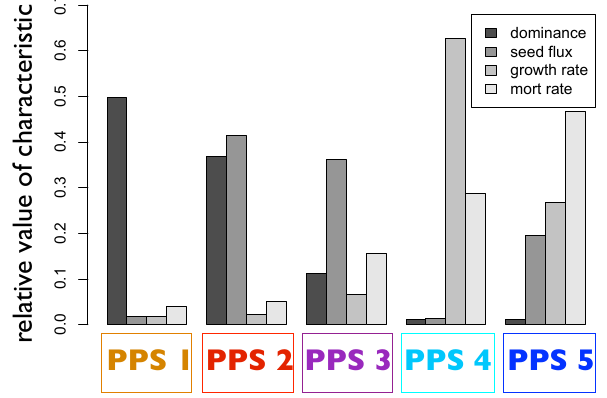
Fig. 5. The five PPSs, each expressed by a different colour with their four characteristics (dominance d i , seed flux f seed ,i , growth rate κ grow ,i and mortality rate κ mort ,i ). The colours refer to the same PPSs in the following figures. Characteristic are normalised by their sum, see Table 2 for specific numeric